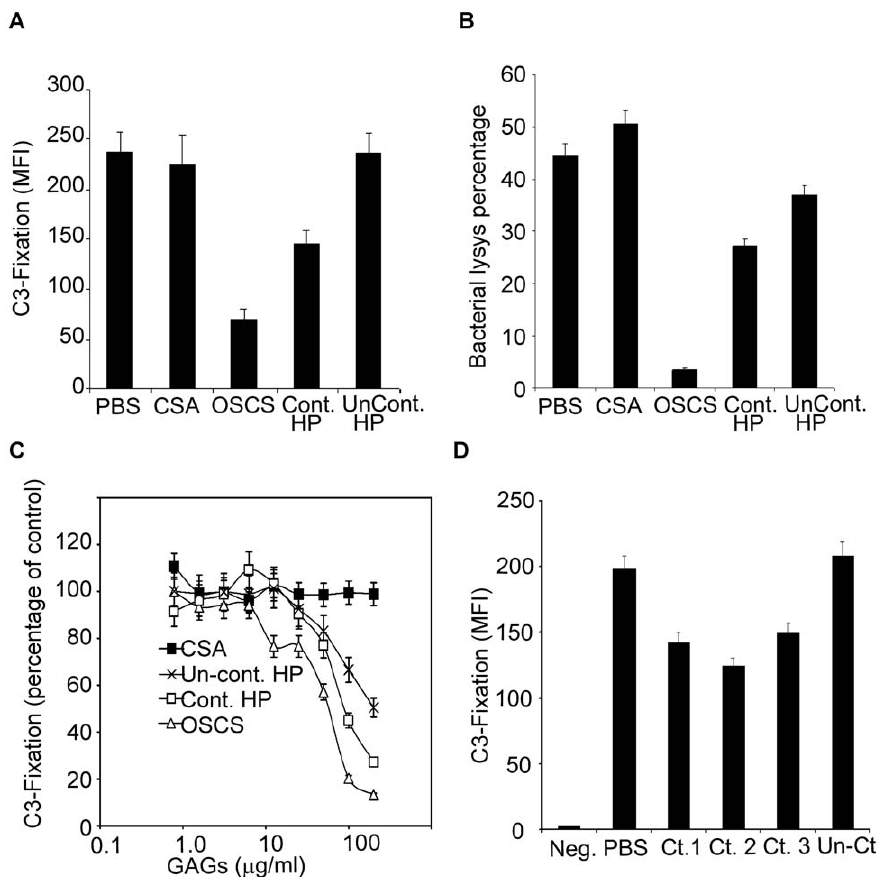
Figure 6. OSCS-contaminated heparin inhibits complement activity. (A) Polyreactive antibody 2E4-treated E. coli BL21 bacteria were incubated with complement plasma in the presence of 20 m g/ml of CSA, OSCS, contaminated heparin, uncontaminated heparin or a control buffer, PBS. Complement fixation on bacteria was determined by PE-labeled anti-C3 monoclonal antibody and flow cytometry; (B) The percentage of bacterial lysis was compared between complement plasmas in the presence of 20 m g/ml of CSA, OSCS, contaminated heparin, uncontaminated heparin or PBS. 3 H-TdR release was used to determine the bactericidal activity of complement as described in Materials and Methods; (C) The percentages of C3 fixation on 2E4-treated E. coli BL21 bacteria, as compared to PBS-treated positive control samples, were evaluated after incubation with complement plasmas that had been pre-incubated with different doses of CSA, OSCS, contaminated heparin, and uncontaminated heparin. (D) Additional lots of heparin were evaluated for inhibition of complement activity as determined by C3 fixation. The abbreviation Ct. as well as Cont. indicates OSCS contamination. Data shown are representative of two to three independent experiments.